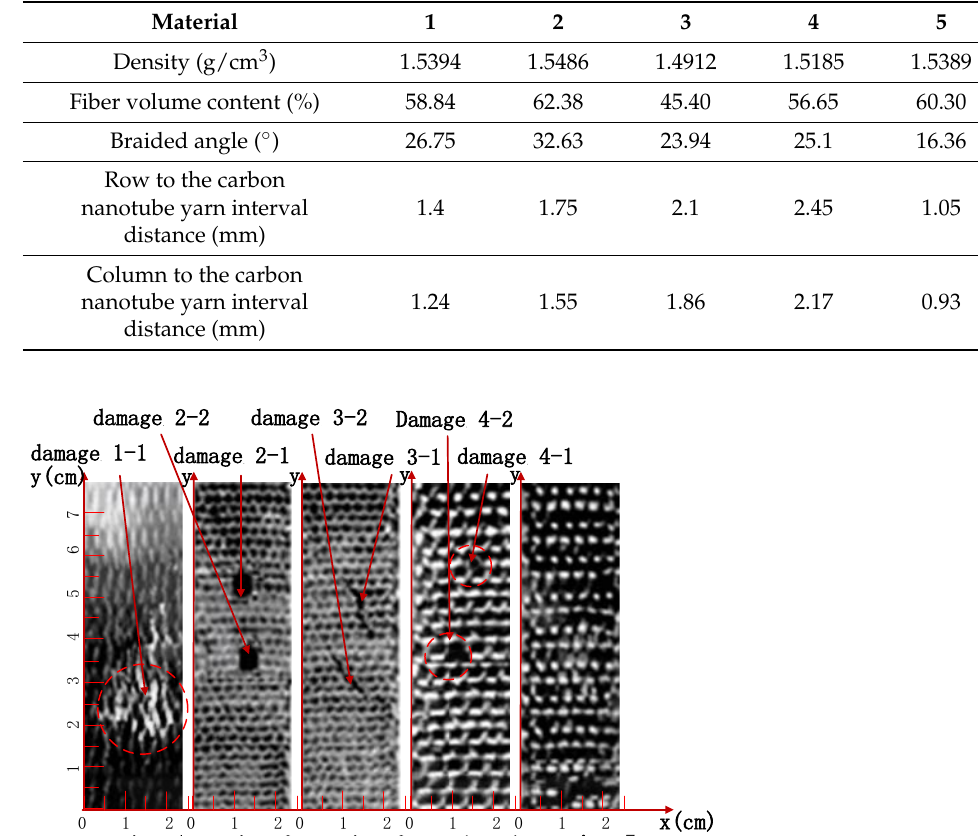
Table 1. Material number and parameters.